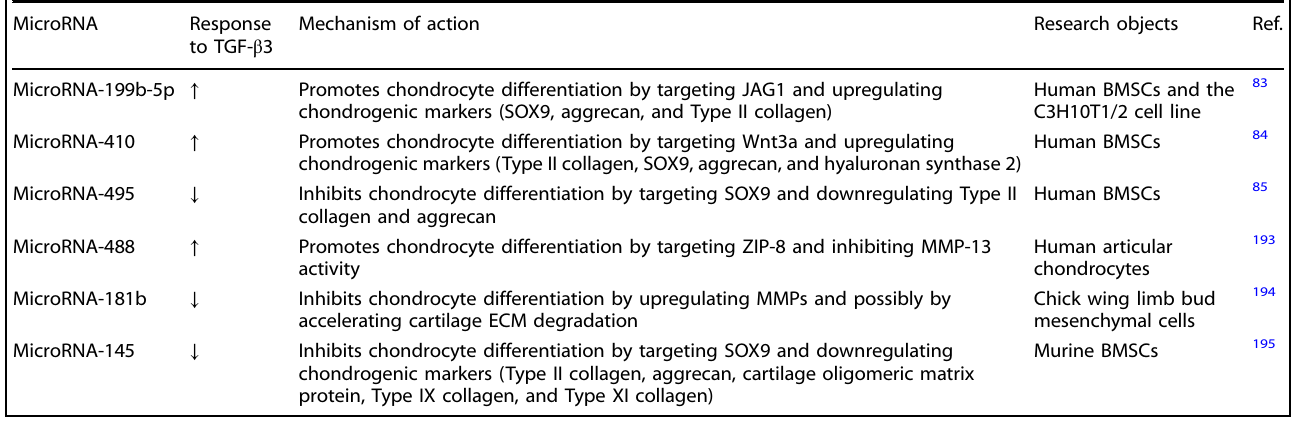
Table 1. TGF- β 3-induced microRNAs that regulate chondrogenic differentiation